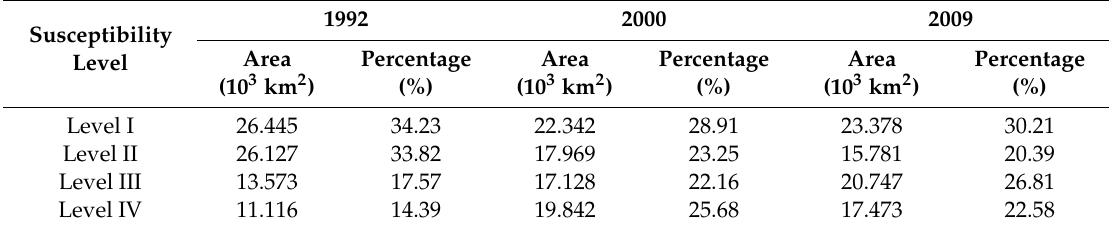
Figure 8. Susceptibility assessment maps for ( a ) 1992, ( b ) 2000, and ( c ) 2009. Table 4. Susceptibility assessment of landslides using LRM scores.